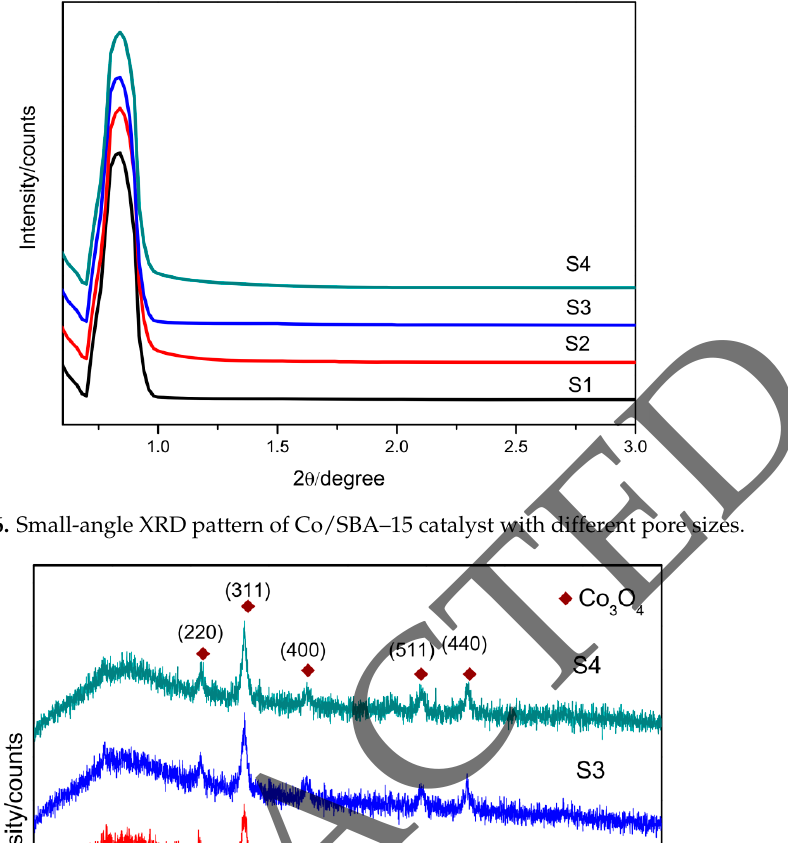
Figure 6. Small-angle XRD pattern of Co/SBA–15 catalyst with different pore sizes.